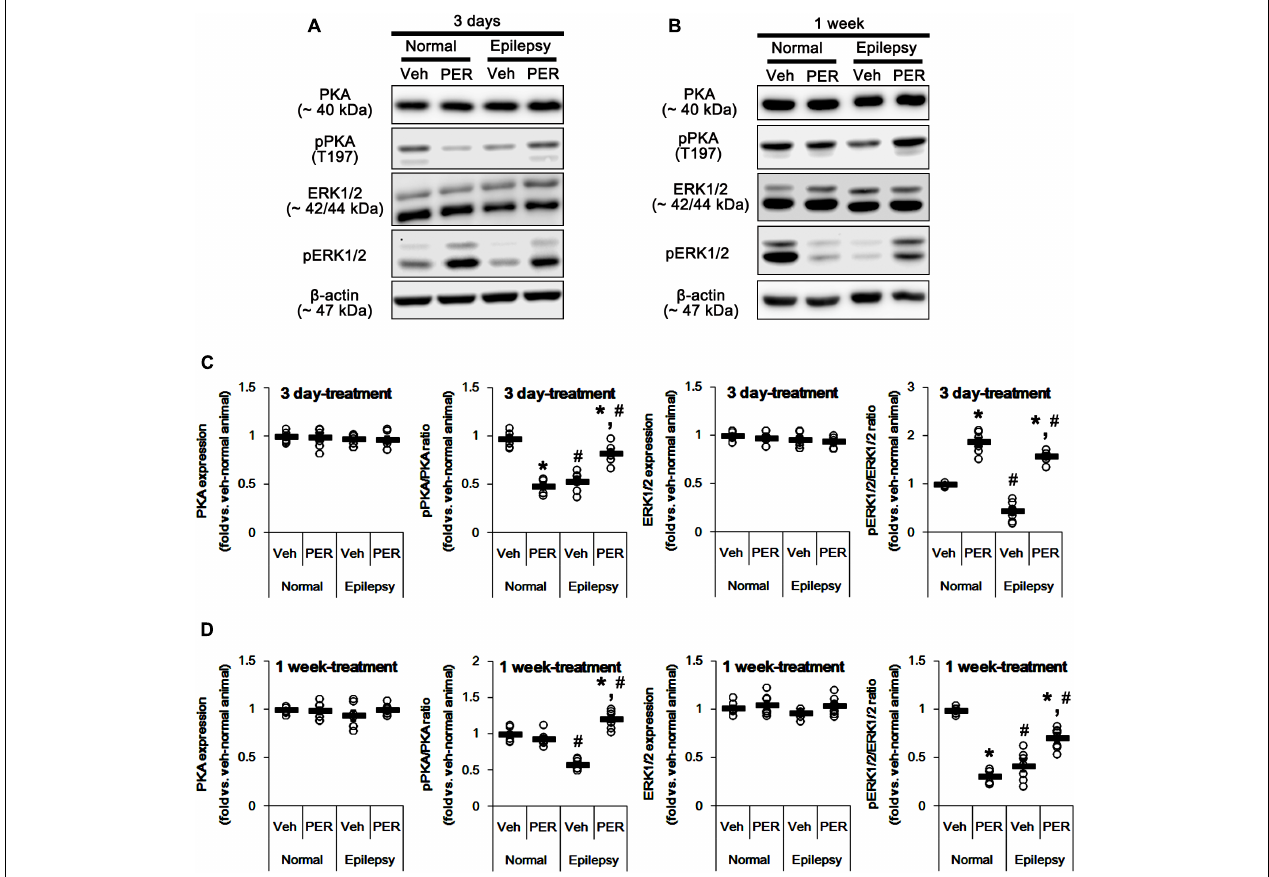
FIGURE 6 | Effects of perampanel on PKA and ERK1/2 expressions and their phosphorylations. (A,B) Representative images for western blot of PKA, phospho (p)-PKA, ERK1/2, and pERK1/2 in the hippocampal tissues obtained from 3-days (A) and 1-week treated groups (B) . Both ERK1/2 and pERK1/2 antibodies clearly show two (p42 and p44) bands. (C,D) Quantifications of PKA, pPKA, ERK1/2, and pERK1/2 levels in 3-days (C) and 1-week treated groups (D) . Open circles indicate each individual value. Horizontal bars indicate mean value. Error bars indicate SEM ( ∗ , # p < 0.05 vs. vehicle-treated animals and normal animals, respectively; n = 7,